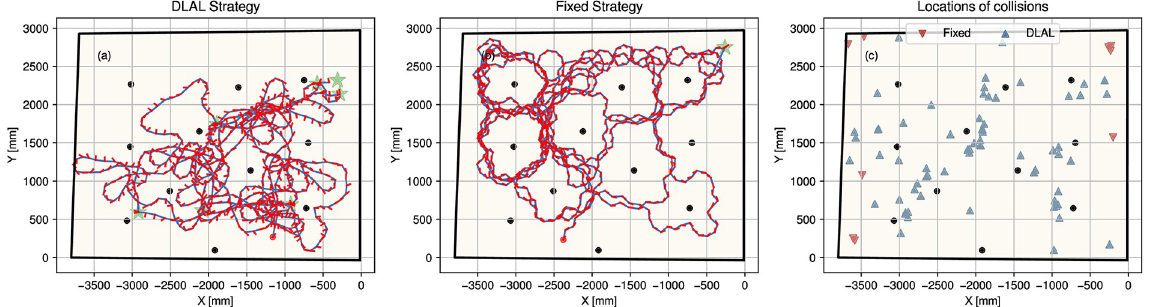
Fig 7. Example trajectories for the robot controlled by (a) the DLAL Strategy and (b) the Fixed Head Strategy. The arena and obstacles are depicted in black. The trajectory of the robot is drawn as a blue line. The head orientation of the robot is shown as short red lines. A green star indicates collisions with obstacles. (c) Locations of the collisions recorded for both strategies across all